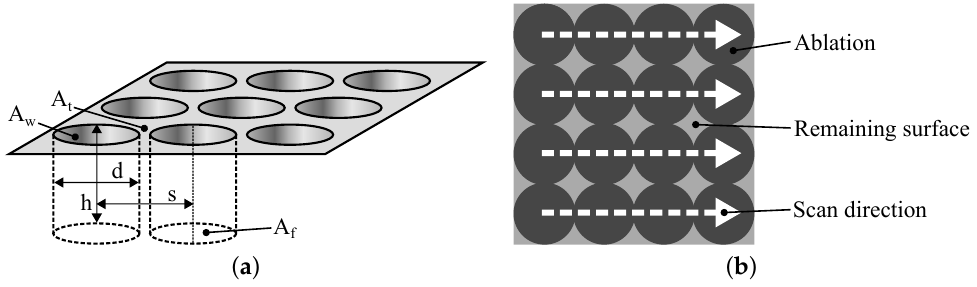
Figure 3. Single pulse drilling strategy: ( a ) schematic illustration of a drilling surface structure, ( b ) strategy for creating pin